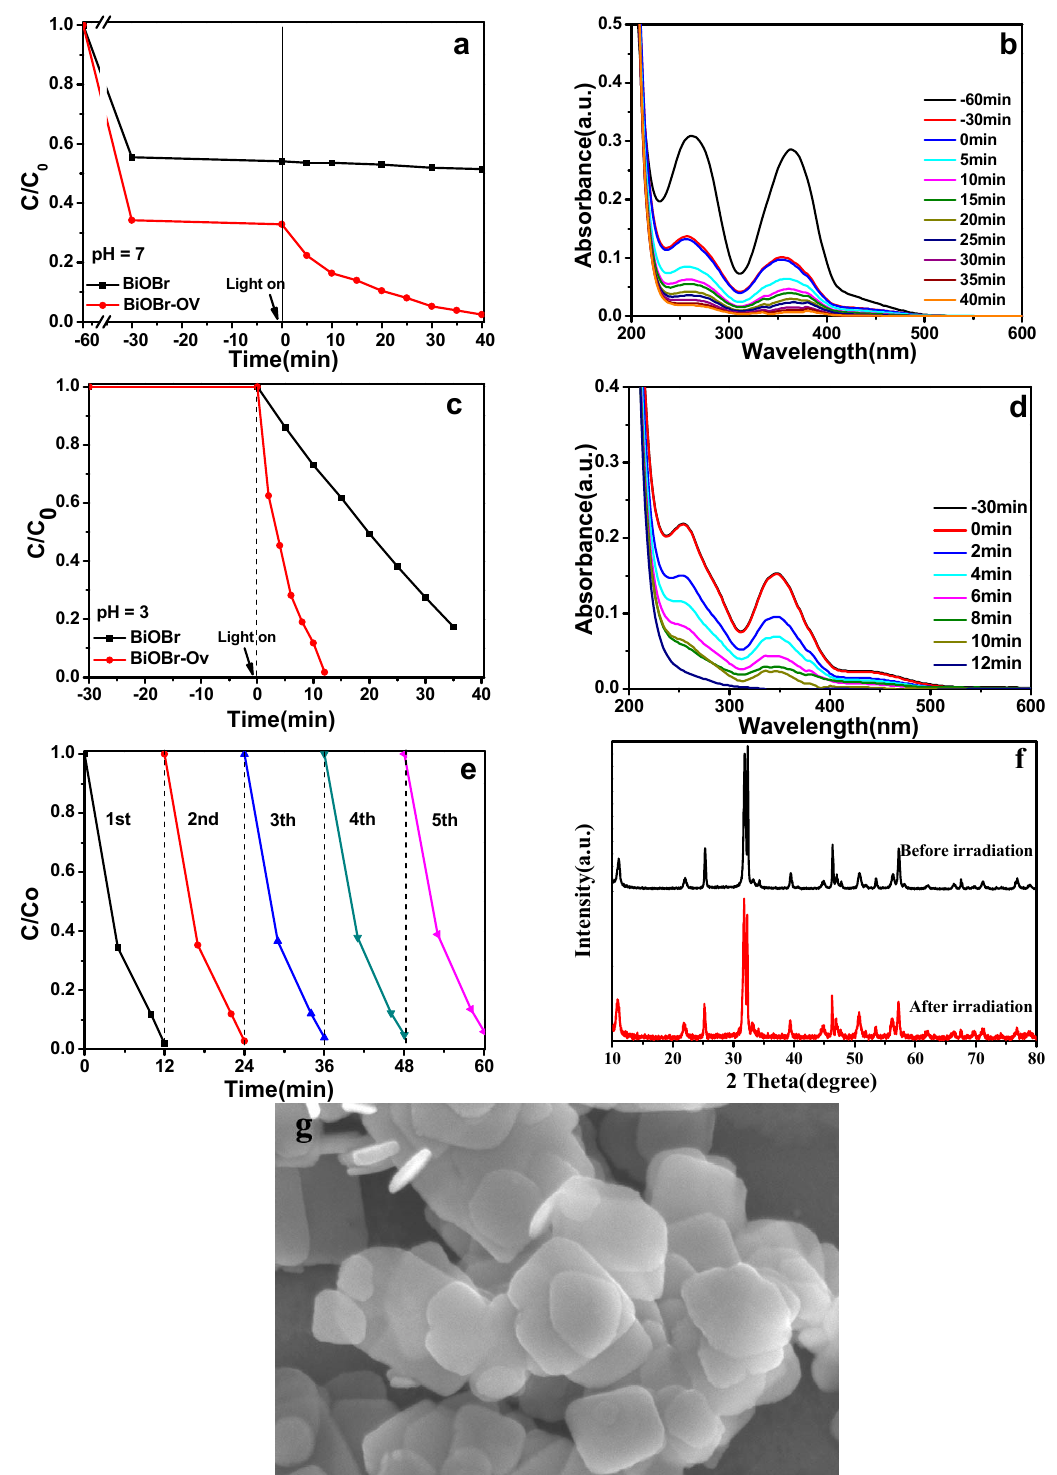
Figure 7. ( a , c ) Photocatalytic activity for reduction of Cr(VI) (20 mg / L) under visible light irradiation at pH = 7 and pH = 3, ( b , d ) UV-Vis absorbance spectrum of Cr(VI); ( e ) cycling times of the photoreduction of Cr(VI); ( f ) XRD patterns of BiOBr-Ov before and after five recycles, and SEM image ( g ) of the BiOBr-Ov after five recycles.